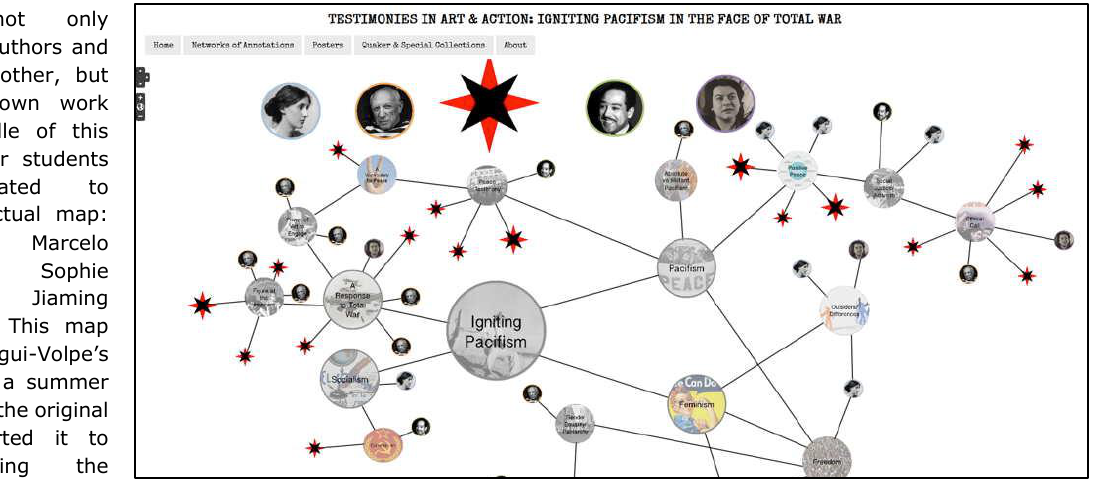
FIGURE 5: MARCELO JUAREGUI-VOLPE’S PROJECT WAS TO CREATE THIS MIND-MAP ON OMEKA AND ADD THE QUAKER